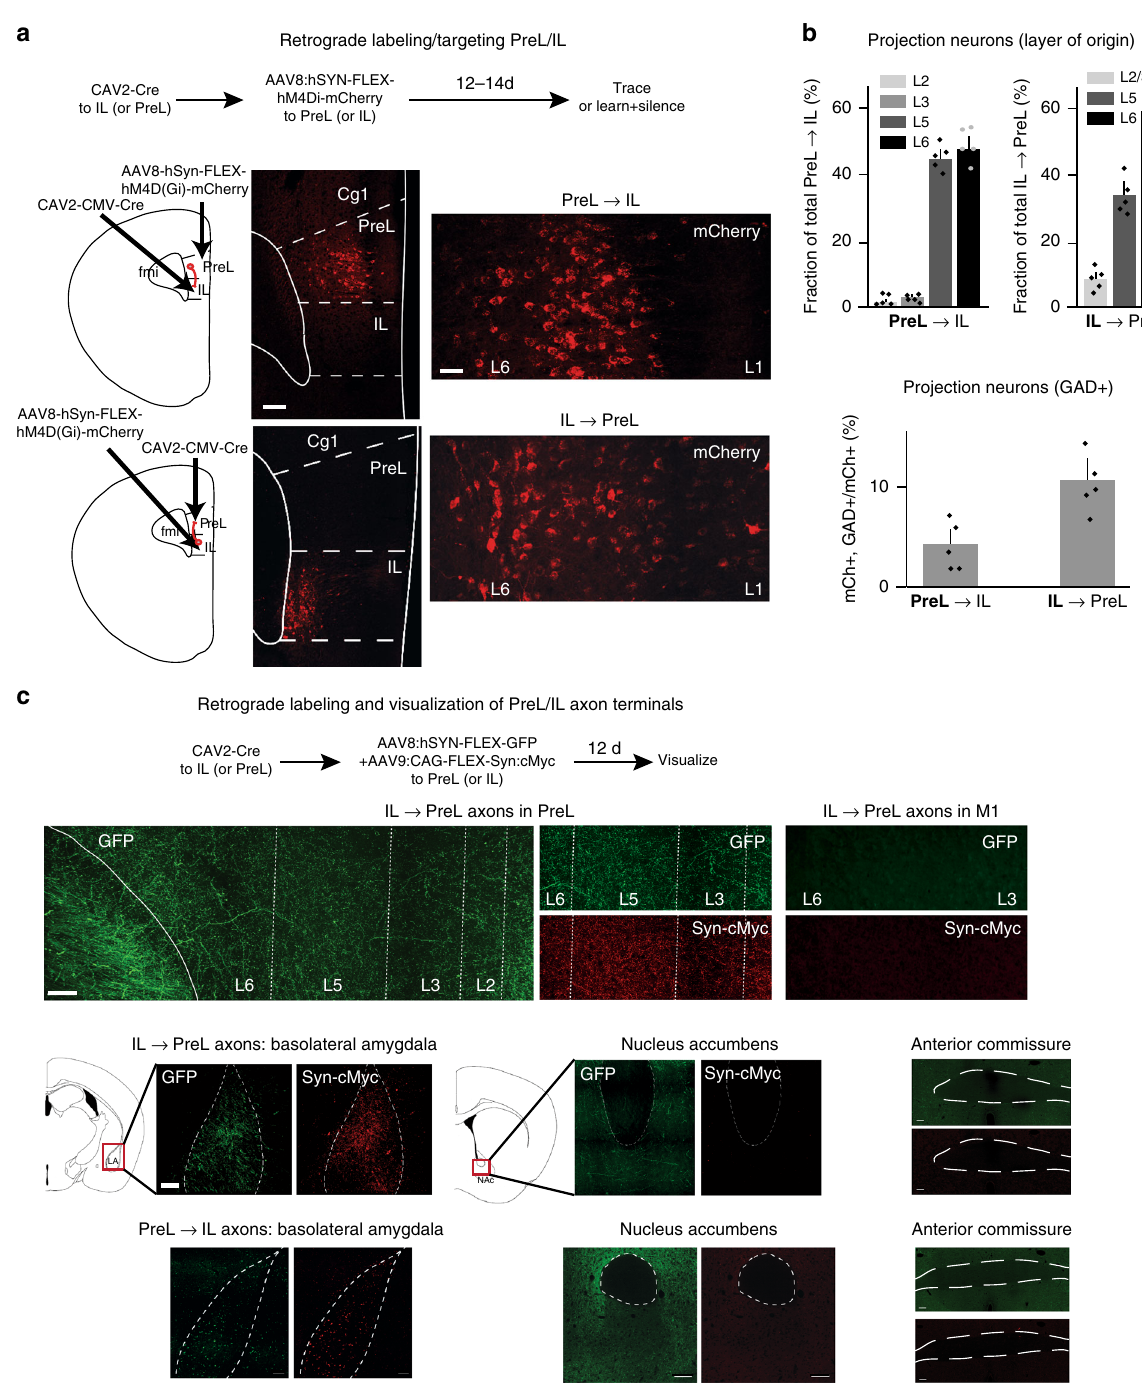
Fig. 1 Reciprocal PreL/IL layer 5/6 connectivity. a Retrograde labeling of PreL → IL and IL → PreL connectivity. Schematic of experimental procedure, and examples of PreL → IL and IL → PreL labeling experiments. Bars: 150 (left), 35 μ m (right). b Cortical layers from which IL neurons project to PreL or PreL neurons project to IL (in % of total projecting neurons; top), and fraction of GAD + neurons among PreL → IL and IL → PreL projecting neurons (mCh, bottom). n = 5 for both PL → IL and IL → PL groups. c Analysis of IL → PreL and PreL → IL projecting axon collaterals. Top: schematic of labeling experiments with GFP and synaptophysin-cMyc fusion protein. Panels: examples of IL → PreL and PreL → IL projecting axon (GFP) collateral terminals (Syn-cMyc) in PreL and BLA, but not in M1, nucleus accumbens and anterior commissure. Bar: 300 μ